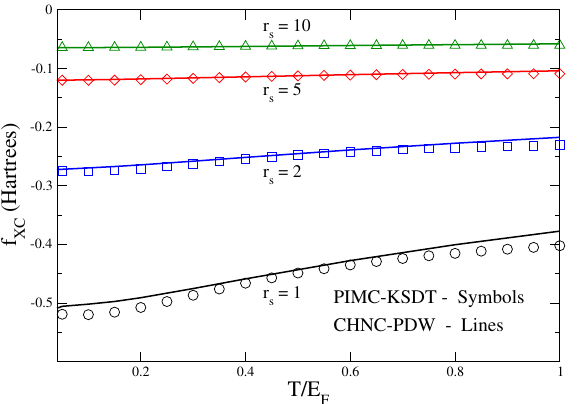
Figure 1. (Color online) Finite- T exchange and correlation free energy f xc ( r s , T ) per electron (Hartrees) versus the reduced temperature T / E F in units of the Fermi energy. The symbols, labeled PIMC-KSDT are the fit given by Karasiev et al. (Reference [60] to the path-integral Monte Carlo (PIMC) data of Brown et al. [59]). The continuous lines, labeled CHNC-PDW are from the classical-map HNC procedure of Perrot and Dharma-wardana [42]. The temperature range 0 < T / E F ≤ 1 is the region of interest for WDM